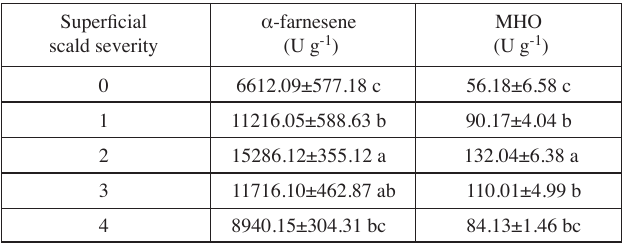
Tab. 1: Headspace accumulation of α-farnesene and MHO in ‘Granny Smith’ apples with different levels of scald severity. The data are the means ± SE of three replicates with five fruits per replicate. Means in each column followed by different letter(s) differ significantly according to Duncan’s multiple range test (p<0.05).